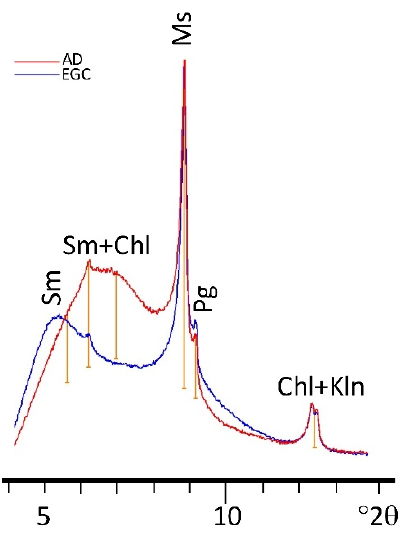
Figure 7. XRD diagram of an oriented aggregate (<2 μ m fraction) of dark clay sediments from the trench. AD: air dried (in red), and EGC: treated with ethylene-glycol (in blue). Kln: kaolinite, Ms: muscovite, Pg: paragonite, Sm: smectite, Chl: chlorite.